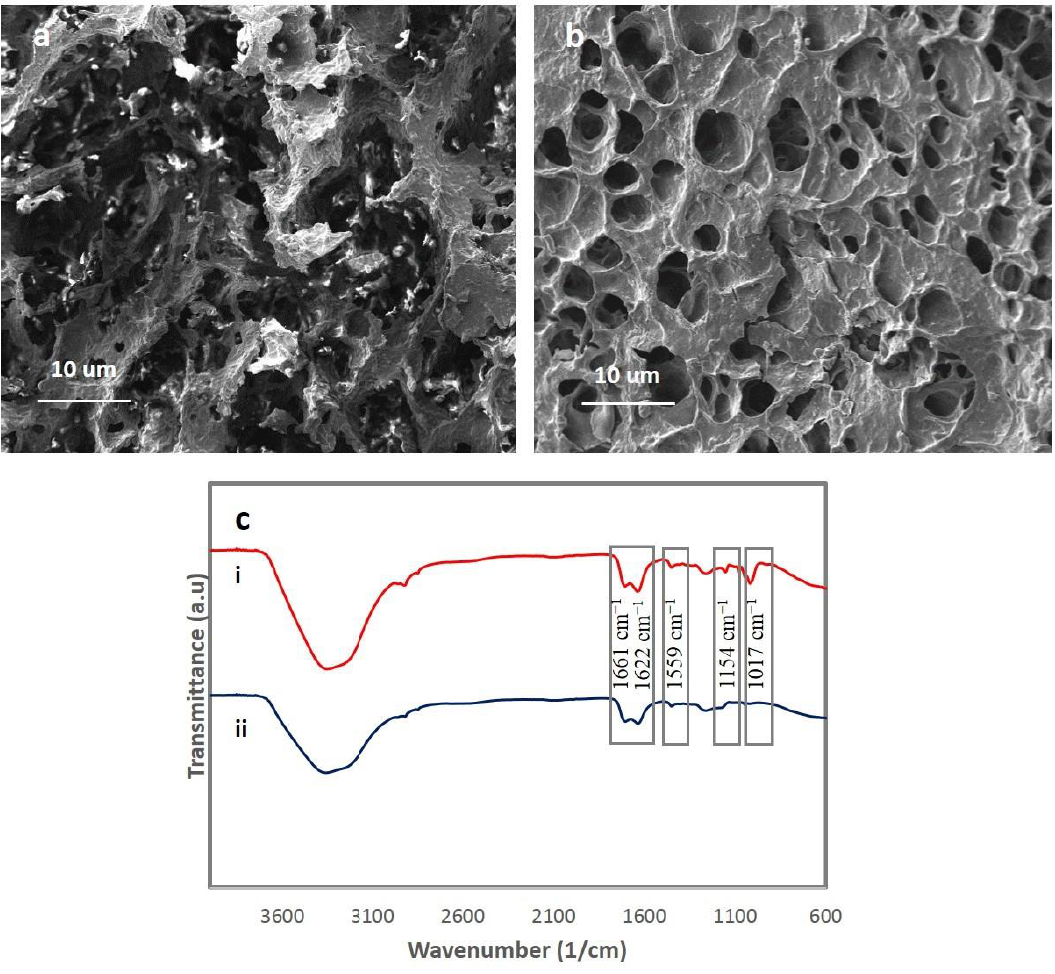
Figure 3. SEM images of ( a ) the unreinforced hydrogel and ( b ) the reinforced hydrogels with 1 wt.% TA-ChNFs; FTIR results of ( ci ) 1 wt.% TA-ChNF-reinforced hydrogels and ( cii ) unreinforced